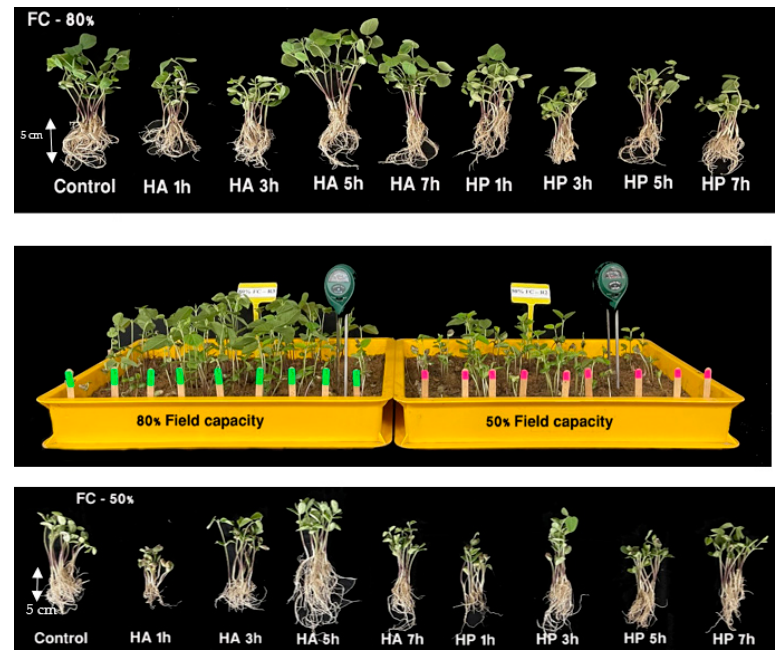
Figure 2. The seedling growth comparison due to different priming treatment and soil moisture content at 10 days after seed sowing under different moisture levels (50% and 80% FC).